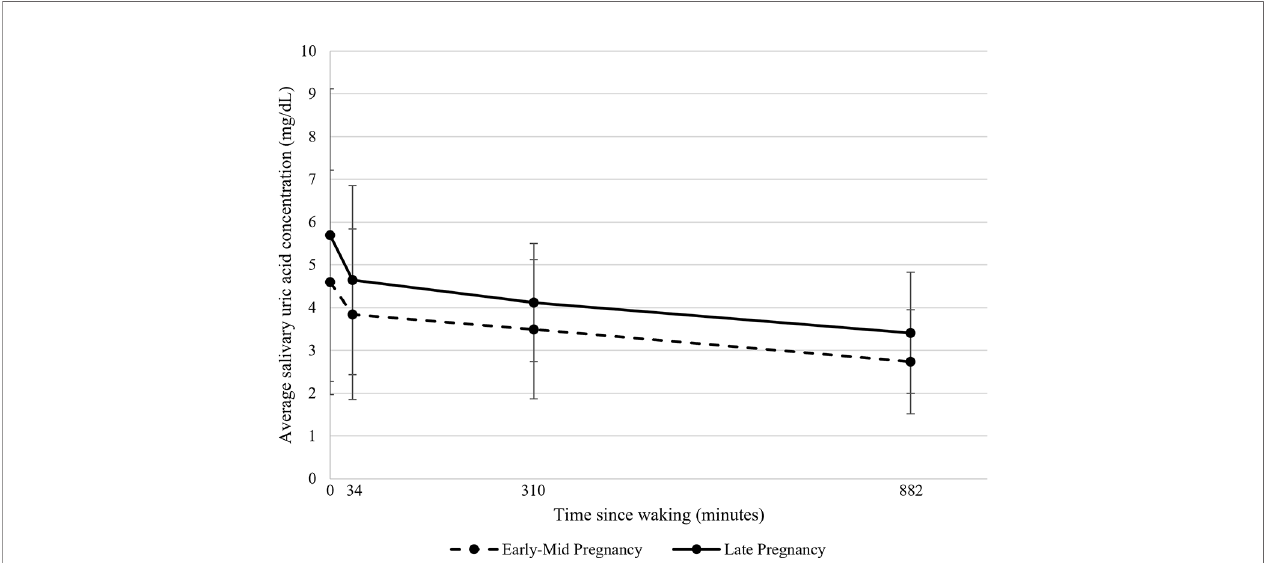
FIGURE 1 | Average salivary uric acid concentrations (mg/dL) across the day during early-mid and late pregnancy among healthy women ( N =43). Raw salivary uric acid (sUA) concentrations are presented with data averaged across all participants for two days in early-mid (5-21 weeks gestation; shown in dotted lines) and two days in late pregnancy (30-34 weeks gestation; shown in solid lines). On each day of data collection, participants were asked to self-collect saliva samples at home upon waking, 30 minutes after waking, at 1130h, and at 2100h. For presentation purposes, the median collection times across all participants and days were used to plot average sUA concentrations as a function of time since waking. Data at 0 minutes represent average sUA for the waking samples; data at 34 minutes represent average sUA for the 30-minutes post-waking samples; data at 310 minutes represent average sUA for the 1130h samples; and data at 882 minutes represent average sUA for the 2100h samples. Error bars represent the standard deviation of the sUA